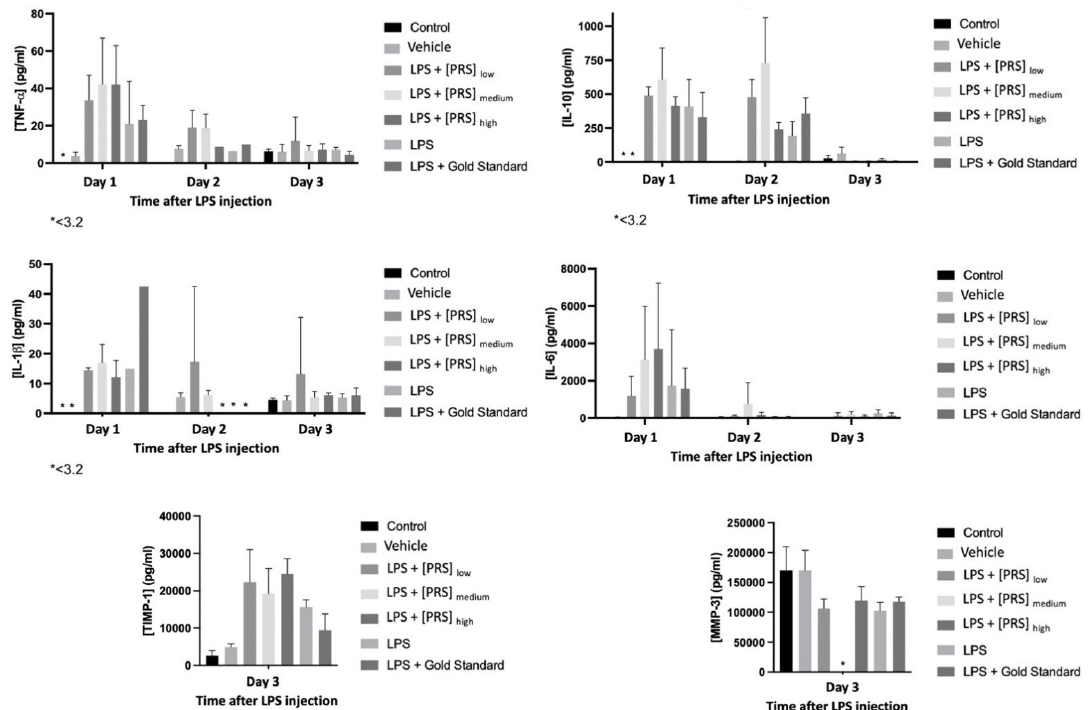
Figure 8. Serum values of the different murine cytokines 1, 2, and 3 days after treatment expressed in pg/mL as the mean of the values of the 5 mice in each of the experimental groups. Evolution of murine cytokines. Asterisks (*) indicate a concentration below 3.2 pg/mL, the detection limit of the assay.